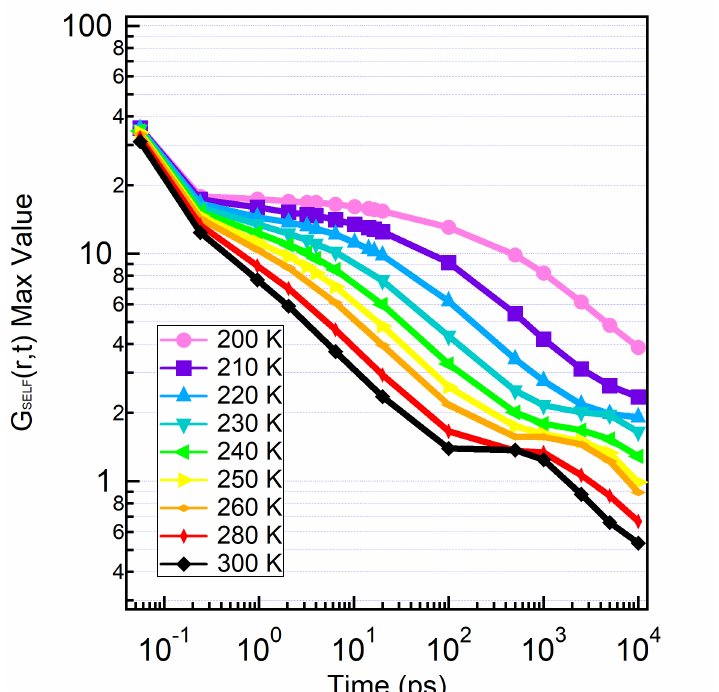
Figure 7. Value of the main maximum of every SVHFs over time. At low temperatures we can see the presence of a plateau, due to the cage effect . At the highest temperature the relaxation appears to follow the α relaxation until 100 ps. From 100 ps to 1 ns we can see a new plateau which shifts at longer times upon cooling. This effect is due to a protein cage effect and it is also related with the